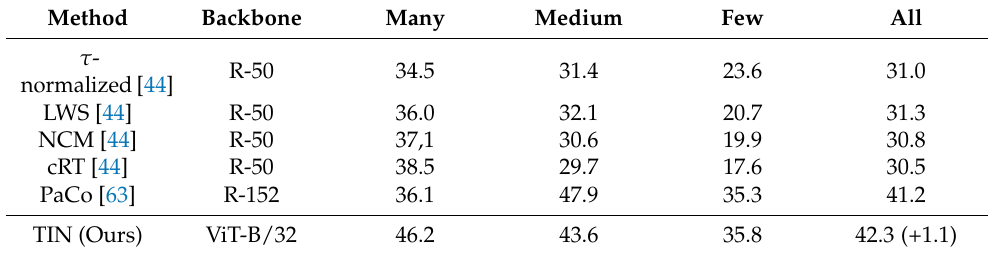
Table 5. Results obtained on Places-LT.